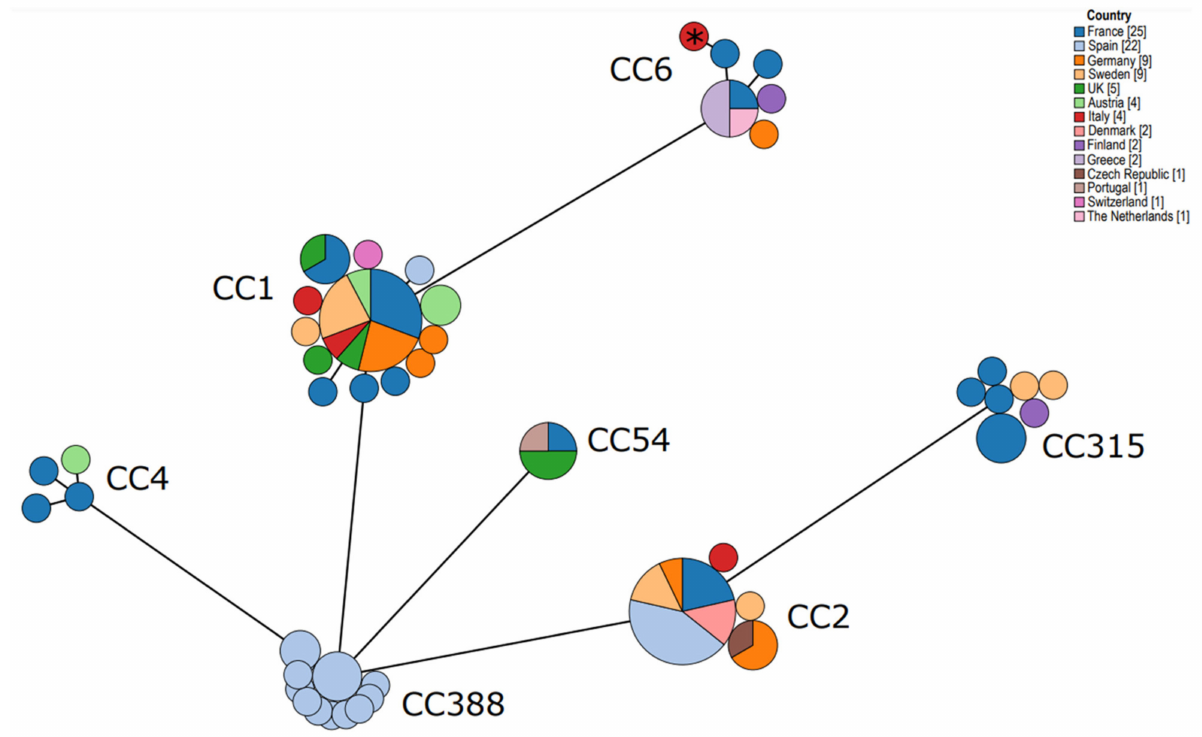
Figure 1. Minimum spanning tree constructed based on the gene scheme used for MLST characterization from a list of 88 sequenced isolates (including the strain under study) chosen from the Institute Pasteur database by selecting all the available L. monocytogenes serogroup IVb isolates from Europe. Clusterization is displayed by CC and country of origin. Asterisk indicates the L. monocytogenes strain under study.